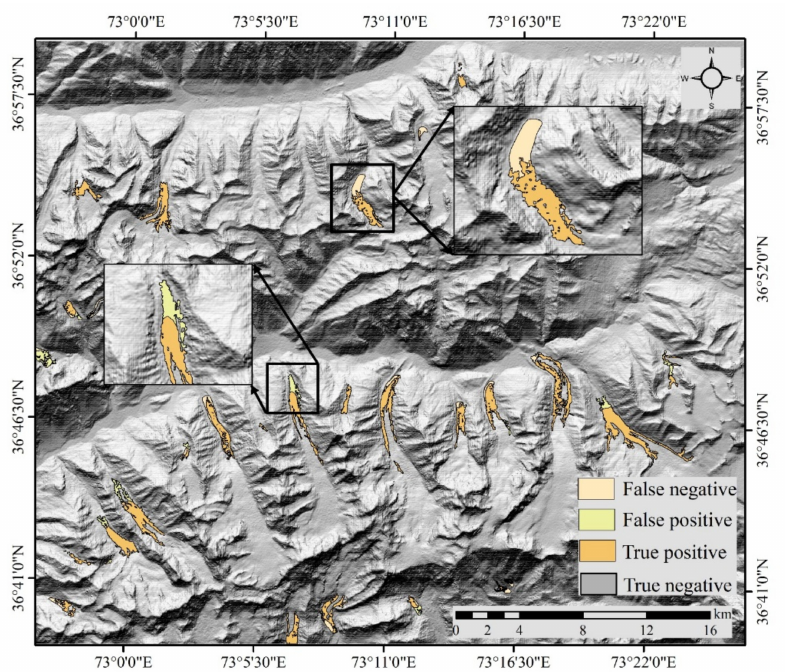
Figure 6. Supraglacial debris mapping at test site 1 (Northwest Karakoram) using the proposed algorithm. False-positives and false-negatives were mapped manually using reference data.